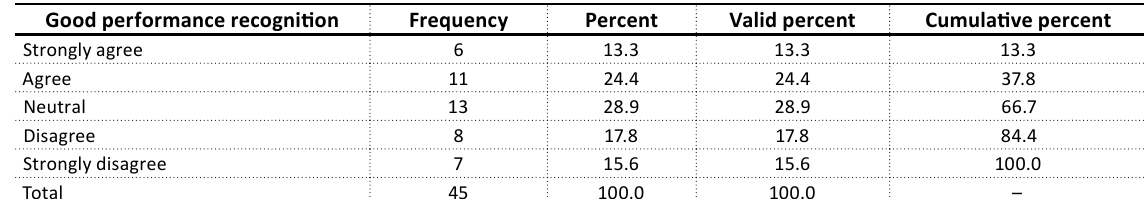
Table 8. Frequency showing the good performance recognition